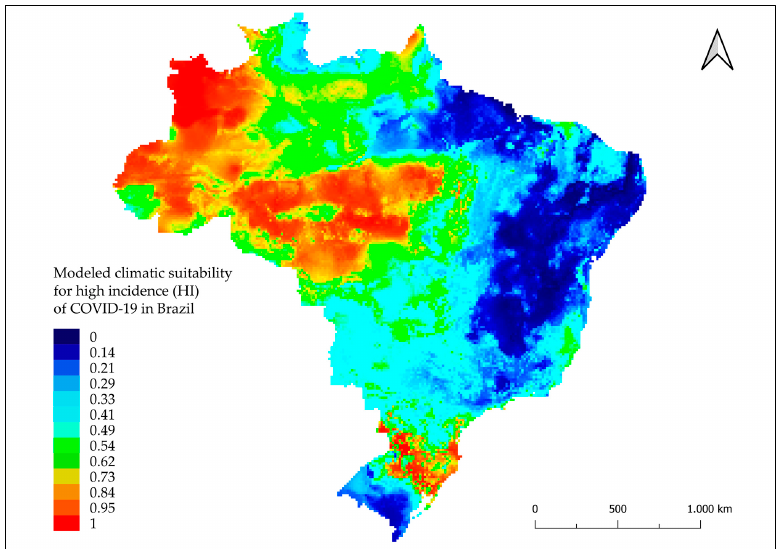
Figure 3. Modeled climatic suitability for high incidence (HI) of COVID-19 in Brazil. Modeled climatic suitability (consensus model) for all seven algorithms under current climate conditions. Data used for modeling was provided by WorldClim [17]. For visualization, maps were built using QGIS version 3.16 (https://qgis.org/pt_BR/site/, accessed on 10 January 2022).